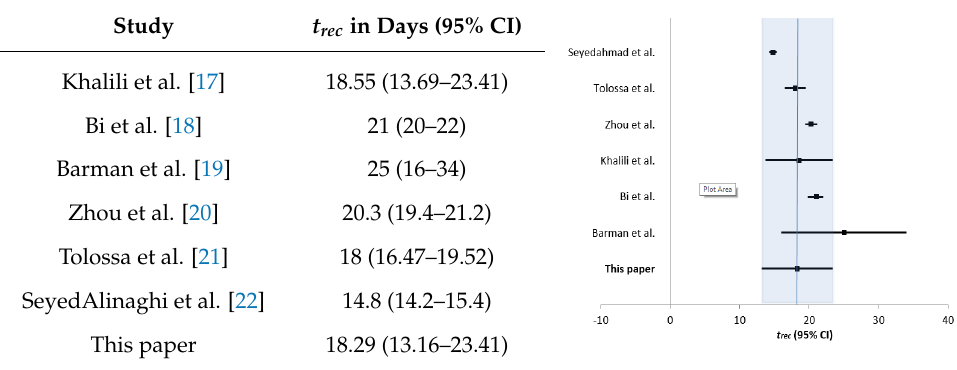
Table 3. Estimations side-by-side with measurements from quality